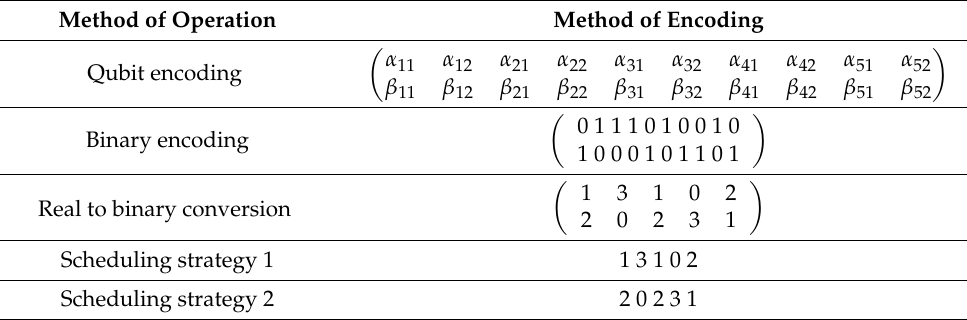
Table 2. Mapping table between Quantum codec and task